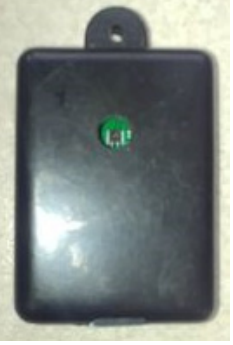
Figure 3. Temperature and humidity sensor used in the clothing